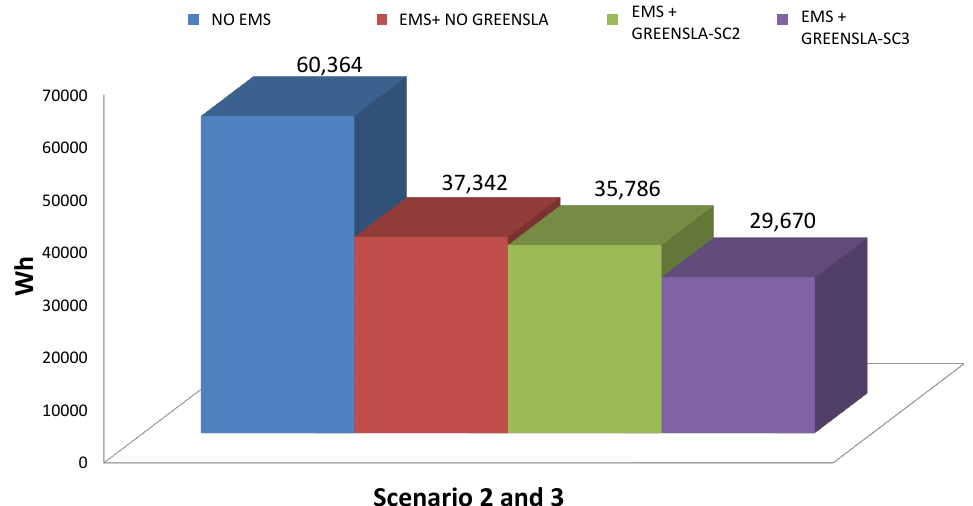
Figure 8. Energy consumption (Wh) of the tested “Demand-Response without Federation